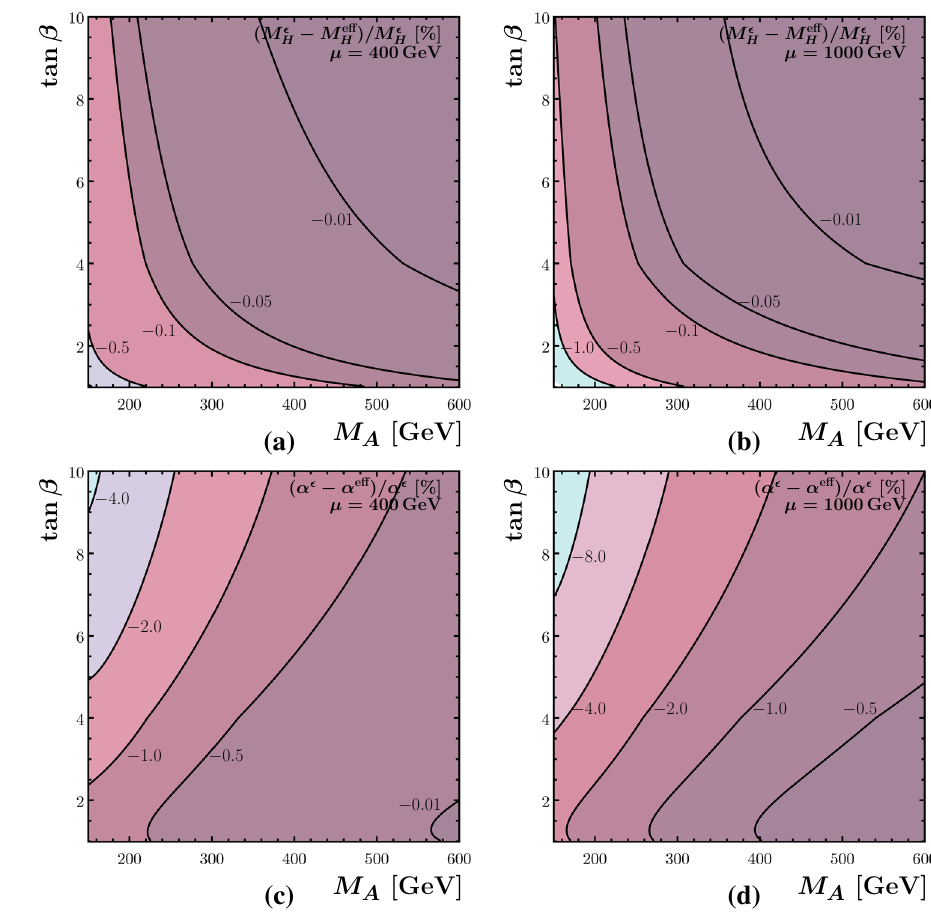
Fig. 3 Difference in the predictions of ( a , b ) the heavy Higgs-boson mass M H in % and ( c , d ) the Higgs-boson mixing angle α in % between the predictions of the hMSSM obtained through Eqs.(24) and (25) and denoted M (cid:6) and α (cid:6) H with the exact values denoted M eff and α eff at NLO , H respectively, as a function of M A in GeV and tan β for ( a , c ) μ = 400GeV, b , d μ = 1000GeV. For μ = 0GeV such differences